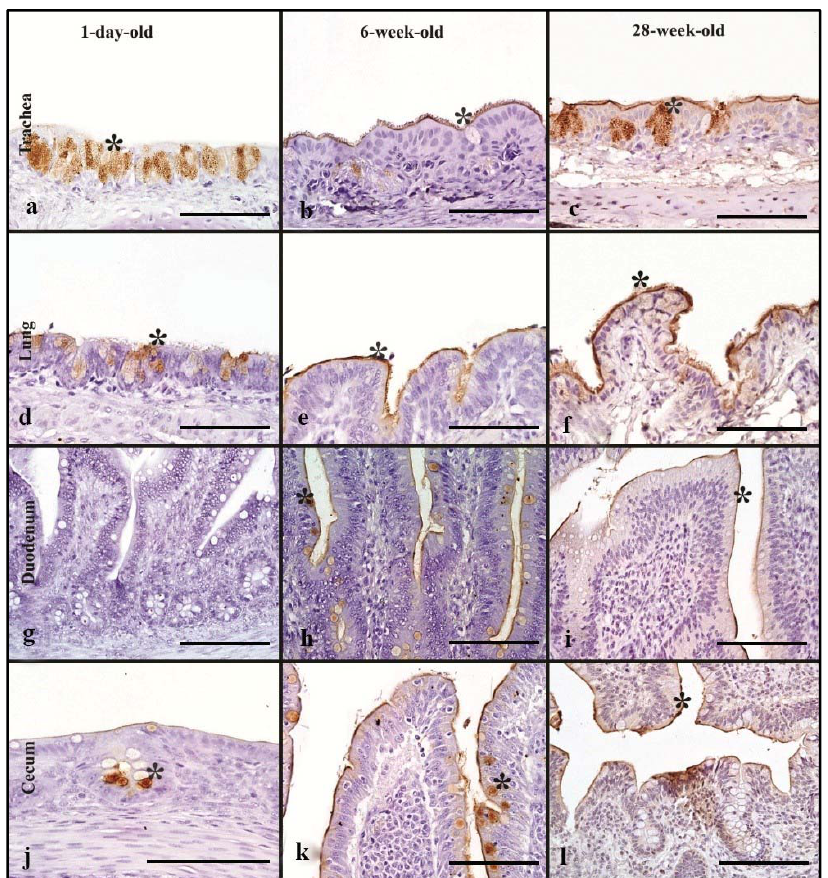
Figure 4. HPAIV H5 rHA binding in chickens of different age groups, denoted by dark brown staining using DAB- HRP via protein histochemistry denoted by asterisk (*). In the trachea, note strong rHA binding in 28-week-old layer chicken ( c ). In the lung, also note strong rHA binding to epithelial cells in 6-week-old and 28-week-old chickens ( e , f ). Significant rHA binding to the enterocytes of the duodenum in 6-week-old birds ( h ). The 6-week-old pullets have strong rHA binding to enterocytes and goblet cells of the cecum ( k ). Scale bar is 50 µm.